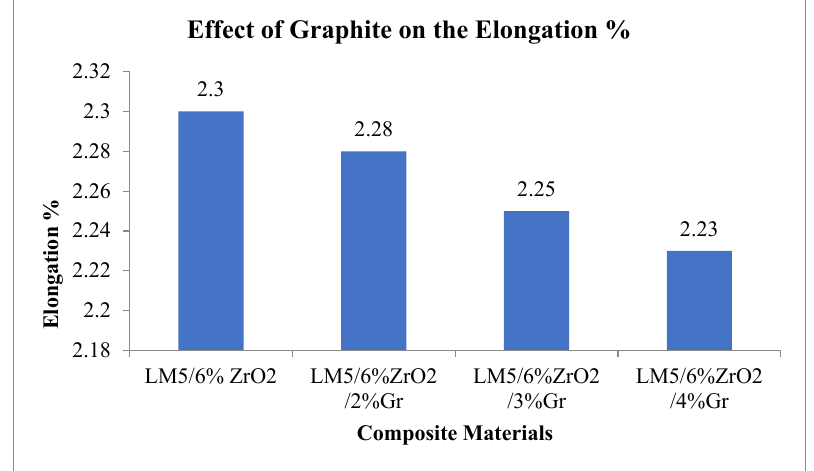
Figure 15. Effect of graphite on the elongation %.